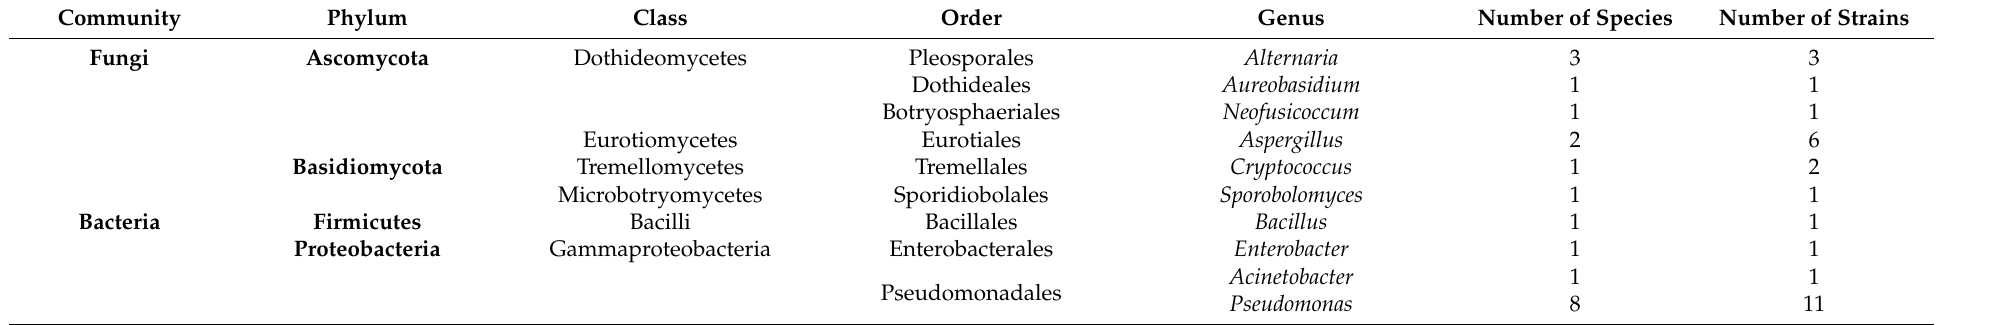
Table 2. Taxonomic groups of fungi and bacteria isolated from water of the Julong hot